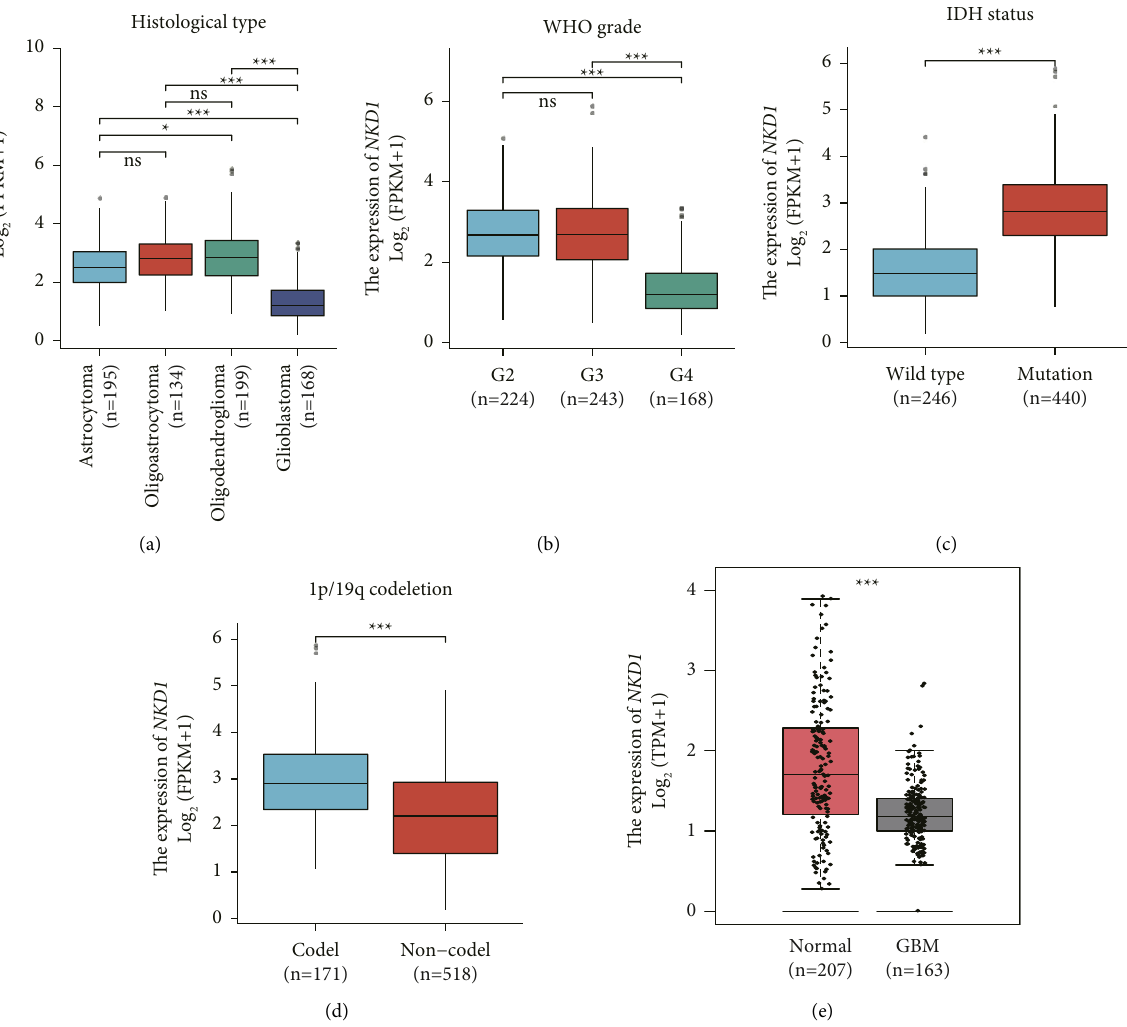
Figure 1: Expression diference of NKD1-mRNA in diferent glioma subtypes: (a) comparison of NKD1-mRNA level in diferent glioma histological subtypes, (b) comparison of NKD1-mRNA level in gliomas with diferent WHO grades, (c) comparison of NKD1-mRNA level in gliomas with wild type or mutated IDH, (d) comparison of NKD1-mRNA level in gliomas with 1p/19q codeletion or non-codeletion, and (e) comparison of NKD1-mRNA level in normal brain tissues and